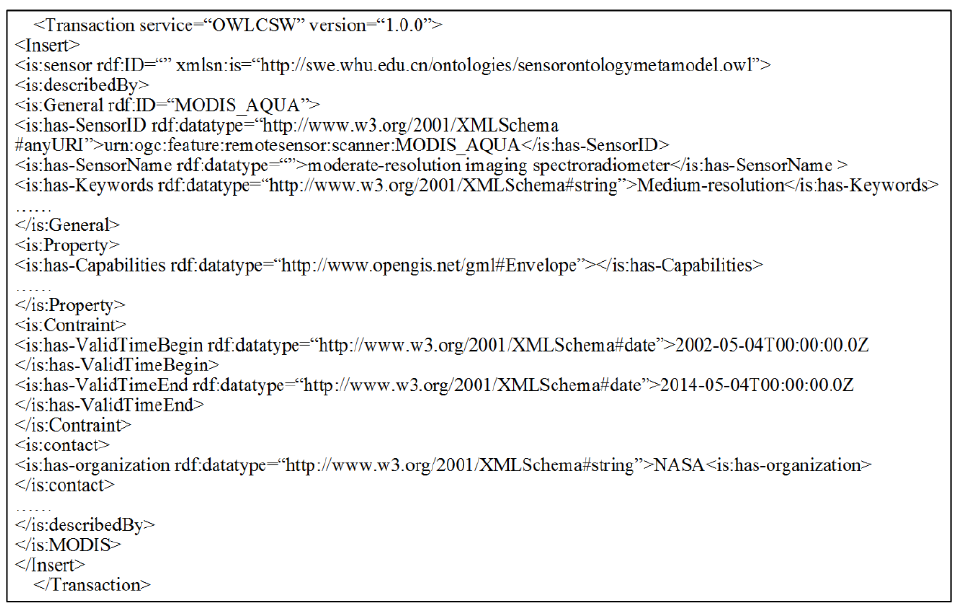
Figure 5. A portion of the “Insert” operation.